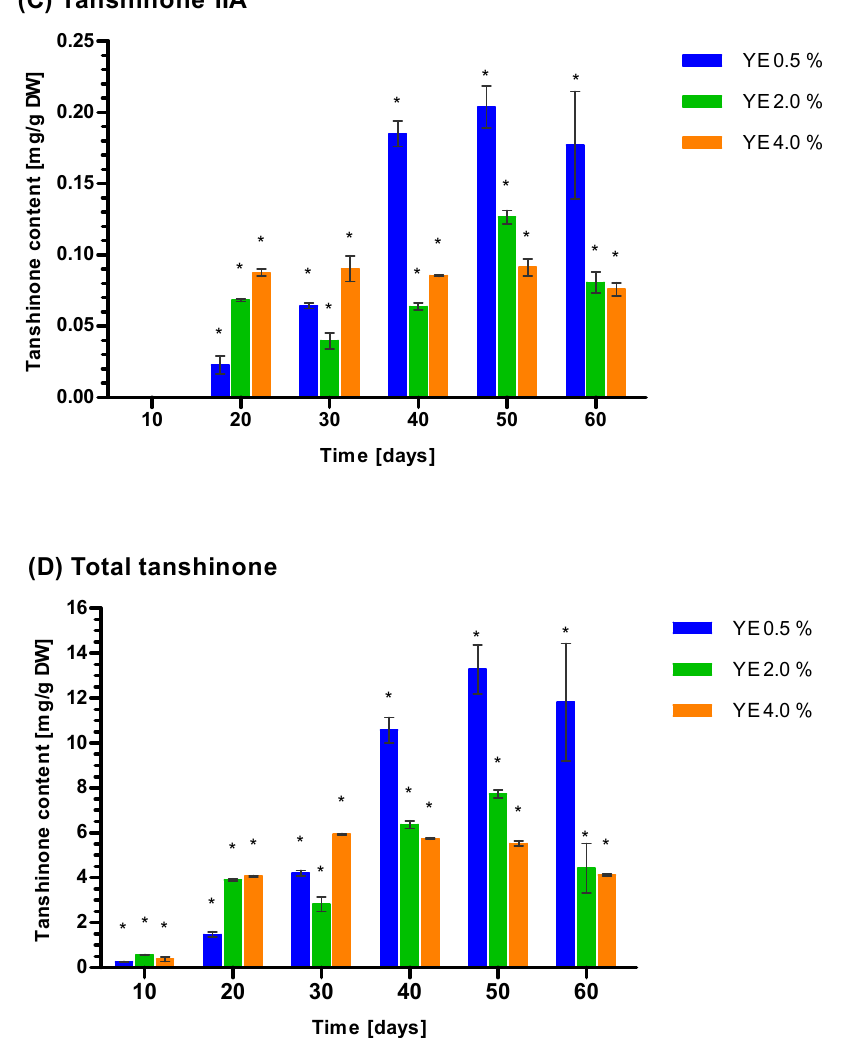
Figure 4. Concentration of three tanshinones dihydrotanshinone I ( A ), cryptotanshinone ( B ), tanshinone IIA ( C ), and total tanshinone ( D ) in S. miltiorrhiza callus presented as a function of yeast extract (YE) concentration (0.5, 2.0, and 4.0%) and elicitation time of 10–60 days. Control and tanhinone I values were not detectable. Differences between control (0) and non-zero tested samples were statistically significant according to the Wilcoxon signed-rank test at p < 0.01. Significant results were marked by an asterisk (*).